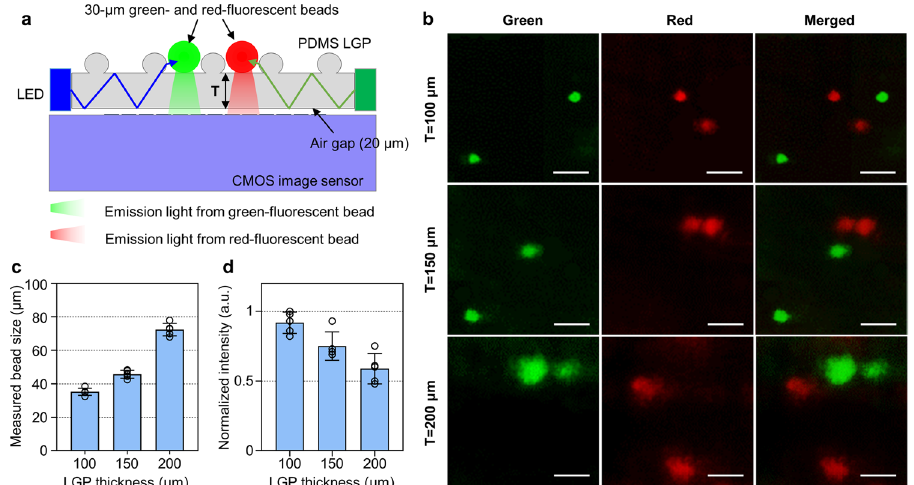
Fig. 4 Comparison of resolution and fl uorescence intensity according to the thickness of the PDMS LGP for observing 30- μ m green- and red- fl uorescent beads. a Schematic diagram showing green- and red- fl uorescent beads using a miniaturized multicolor fl uorescence imaging system integrated with PDMS LGP, where T is the thickness of the PDMS LGP. b Captured images of the multicolor fl uorescent beads according to the thickness of the PDMS LGP. c Measured bead size according to PDMS LGP thickness. d Normalized intensity according to PDMS LGP thickness. Data are presented as mean values + / − s.d. with individual data points (white circle; n = 5 for all data, n is the number of the measured beads). Scale bar: 100 μ m